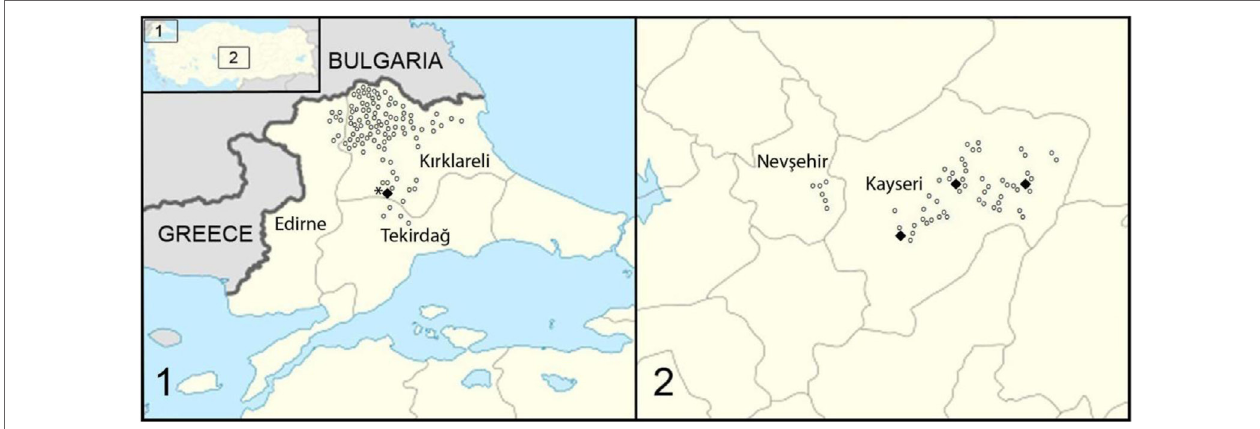
FigUre 1 | Study area and locations where fecal samples were collected in Turkey, (1) in Thrace and (2) in central Anatolia (Asia Minor). Open dots represent the location of samples negative for Echinococcus multilocularis ; bold dots represent samples with positive E . multilocularis PCR result. The star localizes the origin of the fox infection with E . multilocularis found in the sixties